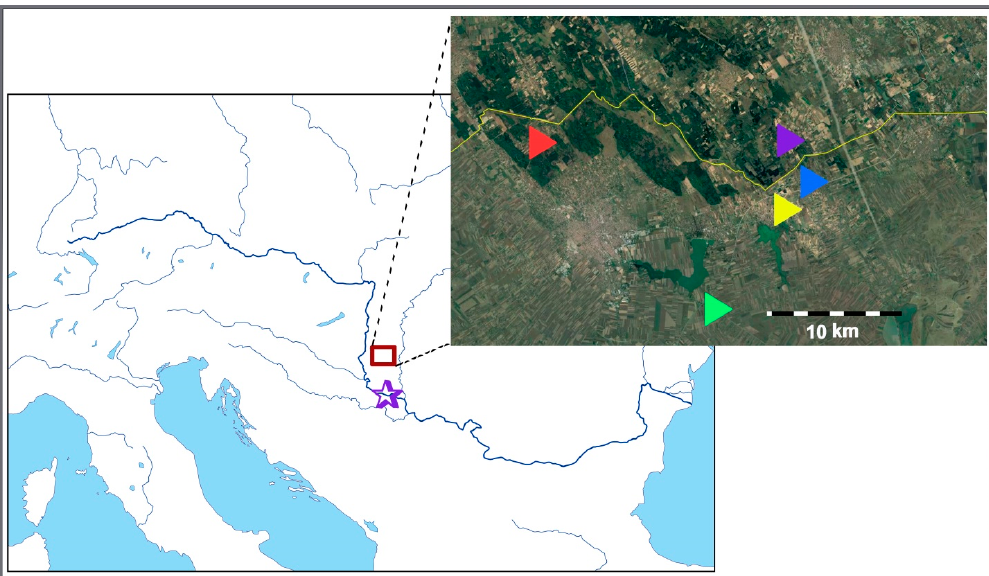
Figure 6. Map of south-east Europe with a detailed terrain map of the study area of Subotica Sands. The colored triangles on the extracted Google map* represent localities of existing populations in the area: red—Majdan (MJ); green—Pali ć (PA); yellow—Hajdukovo (HA); blue—Ba č ki Vinogradi (BV); purple—Ásotthalom (AS). The purple star on the basic map represents approximate position of Fruška Gora Mt. populations of C. erythraea —Iriški venac (IV) and Beo č in (BE). * Satellite image downloaded from Google Earth software (Google Earth Pro, v. 7.3.2.5776, recording date: March 31st, 2019, Subotica, view height: 32.33 km, DigitalGlobe 2019, download date: 6 May 2019).